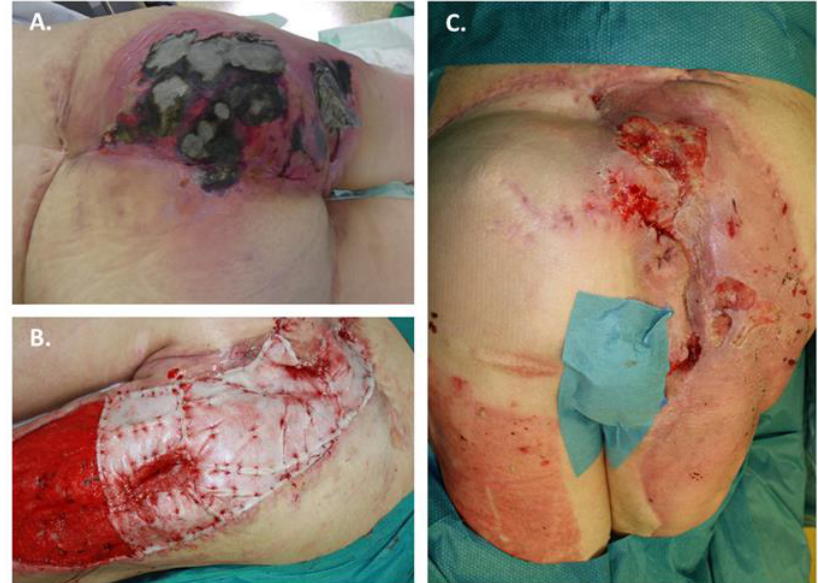
Figure 4. A case of pressure ulcer treated with BTM. A 47-year-old female was admitted with an extensive skin soft tissue defect in the gluteal and sacral region due to a pressure ulcer: ( A ) Wound situation on admission; ( B ) At the time of BTM implantation Pseudomonas aeruginosa , Enterococcus faecalis and Staphylococcus aureus were detected microbiologically; ( C ) Wound situation after removal of the overknot dressing with a loss of the split-skin and BTM on an area of 10%.